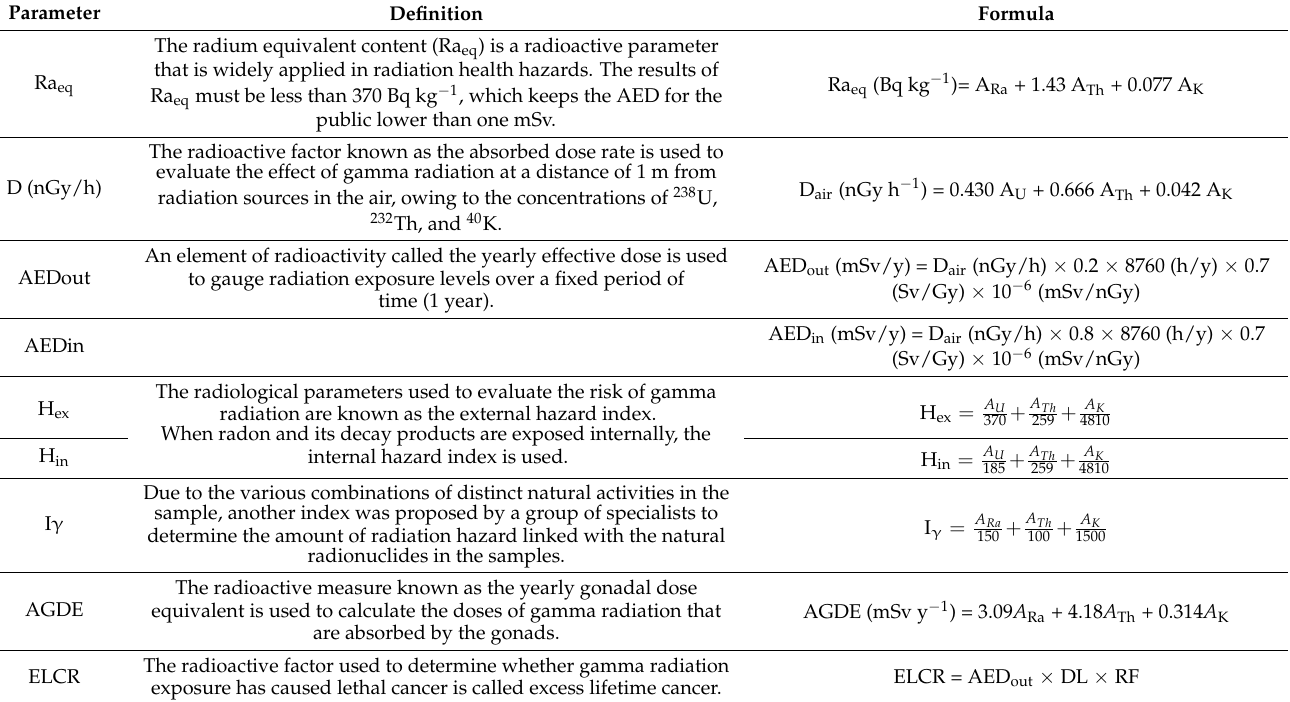
Table 1. Important radiological parameters and indices